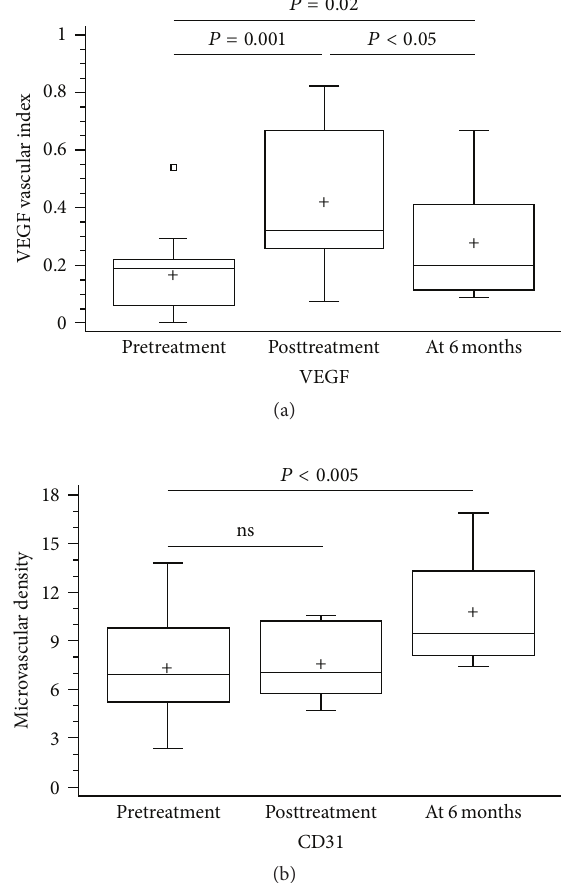
Figure 3: Evaluation of immunostaining for vascular endothelial growth factor (VEGF vascular index) and CD31 (microvascular density) in rectal mucosa of patients with radiation proctitis due to radiotherapy for prostate cancer at three time settings. VEGF vas- cular index (a) was significantly increased at the completion of irra- diation and remained so, at 6 months. In contrary, microvascular density (b) was unchanged at the completion of radiotherapy but increased significantly at 6